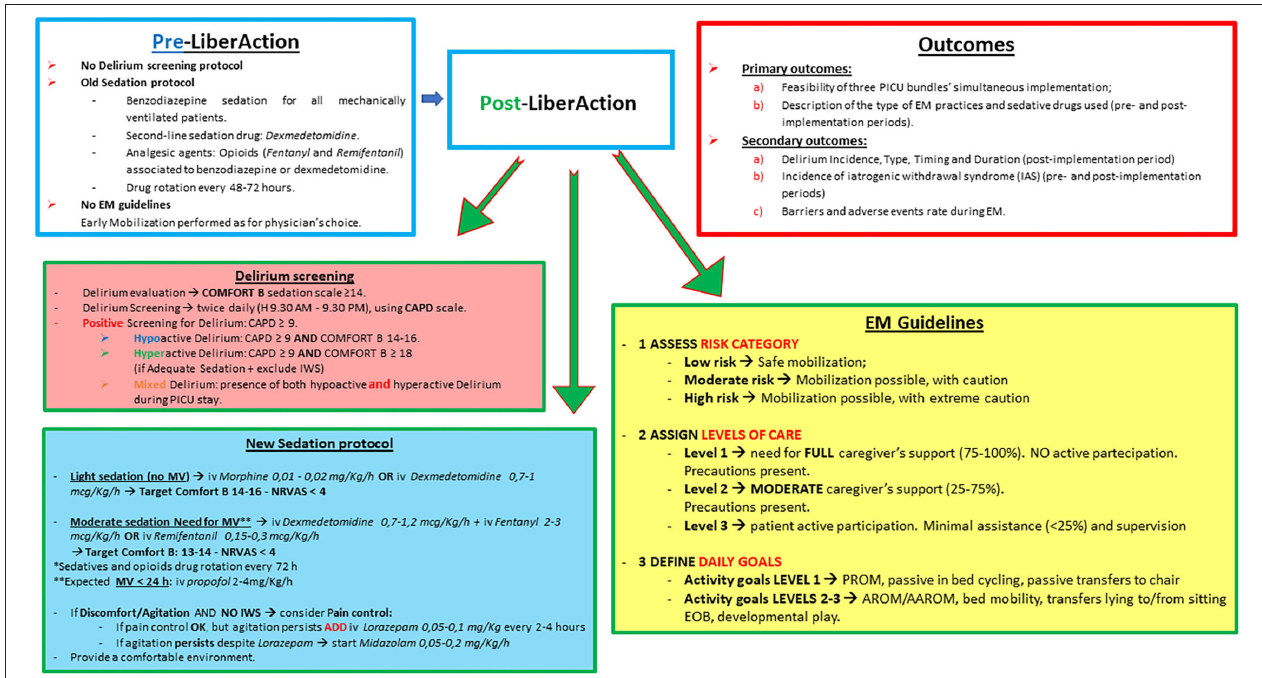
FIGURE 1 | PICU practices in the pre/post-implementation period and study outcomes. EM, Early mobilization; IWS, Iatrogenic withdrawal syndrome; MV, mechanical ventilation; NRVAS, nurse reported visual analogic pain scale; PROM, passive range of motion; AROM, active range of motion; AAROM, assisted/active range